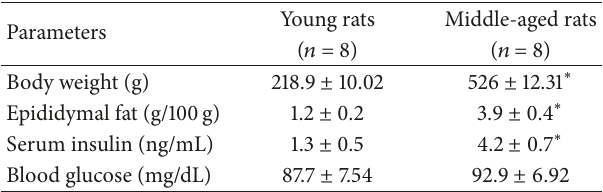
Table 1: Descriptive characteristics of young and middle-aged rats ( 𝑛 = 8) before exercise protocols expressed as mean ±